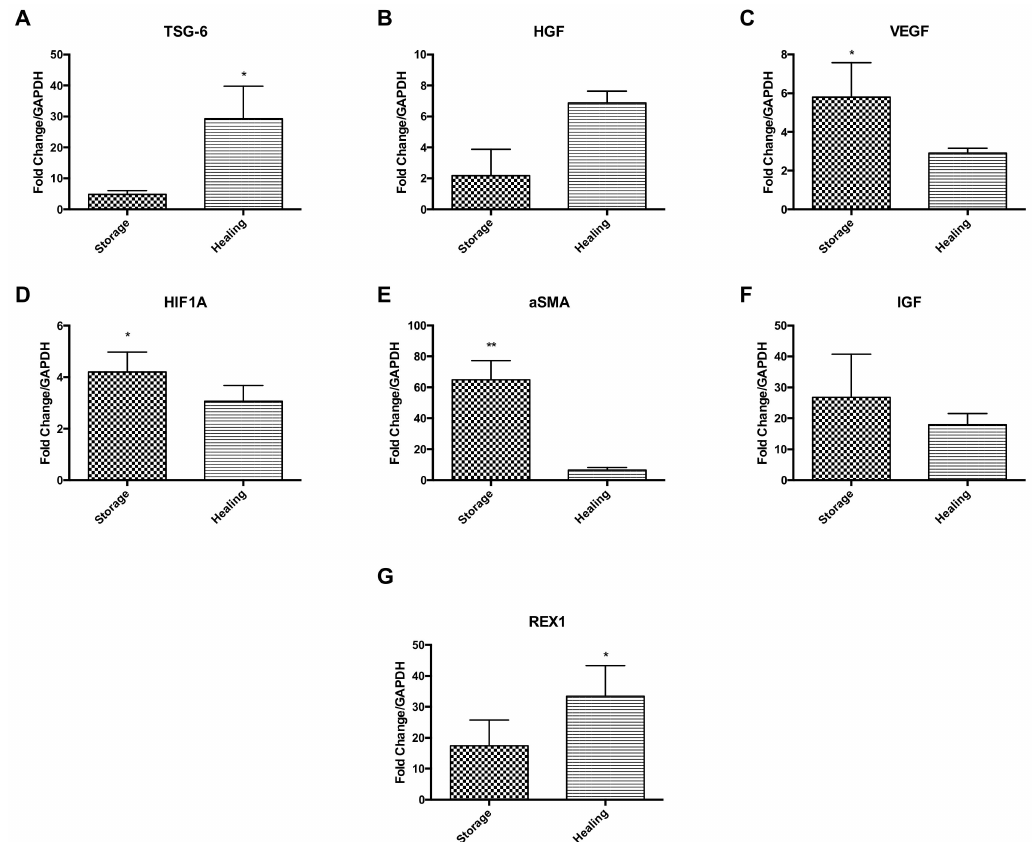
Figure 5. Key Ad-MSCs markers expressions were assessed, comparing stored bandages to bandages used in healing. ( A ) TSG-6, ( B ) HGF, ( C ) VEGF, ( D ) HIF1A, ( E ) α SMA, ( F ) IGF, and ( G ) REX1. Storage, Ad-MSCs bandages stored at 15 ◦ C; Healing; Ad-MSCs bandages stored at 15 ◦ C and used in scratch healing. Values are presented as mean ± SEM of three separate adipose-derived stem cells donors; asterisks represent significance: ** = p < 0.01; * = p <